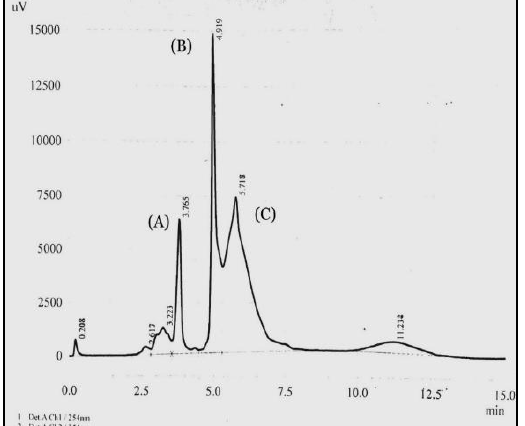
Figure 5. TLC chromatogram of F-1 for Abrus pretacorius plant using silica gel GF 254nm as adsorbent and S4 K [ Dichloromethane: methanol: water: formic acid: diethylamine (72.3: 25: 2.5: 0.1: 0.1)] as a mobile phase. Detecting by spraying with dragendorrf's reagent. Std: Abrine standard.